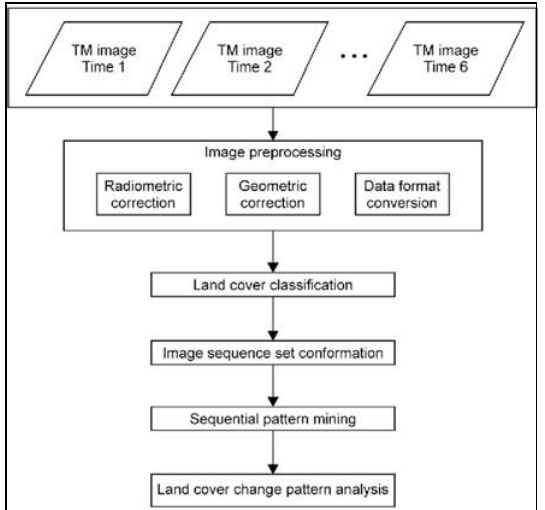
Figure 3. The flowchart of the experimental procedure